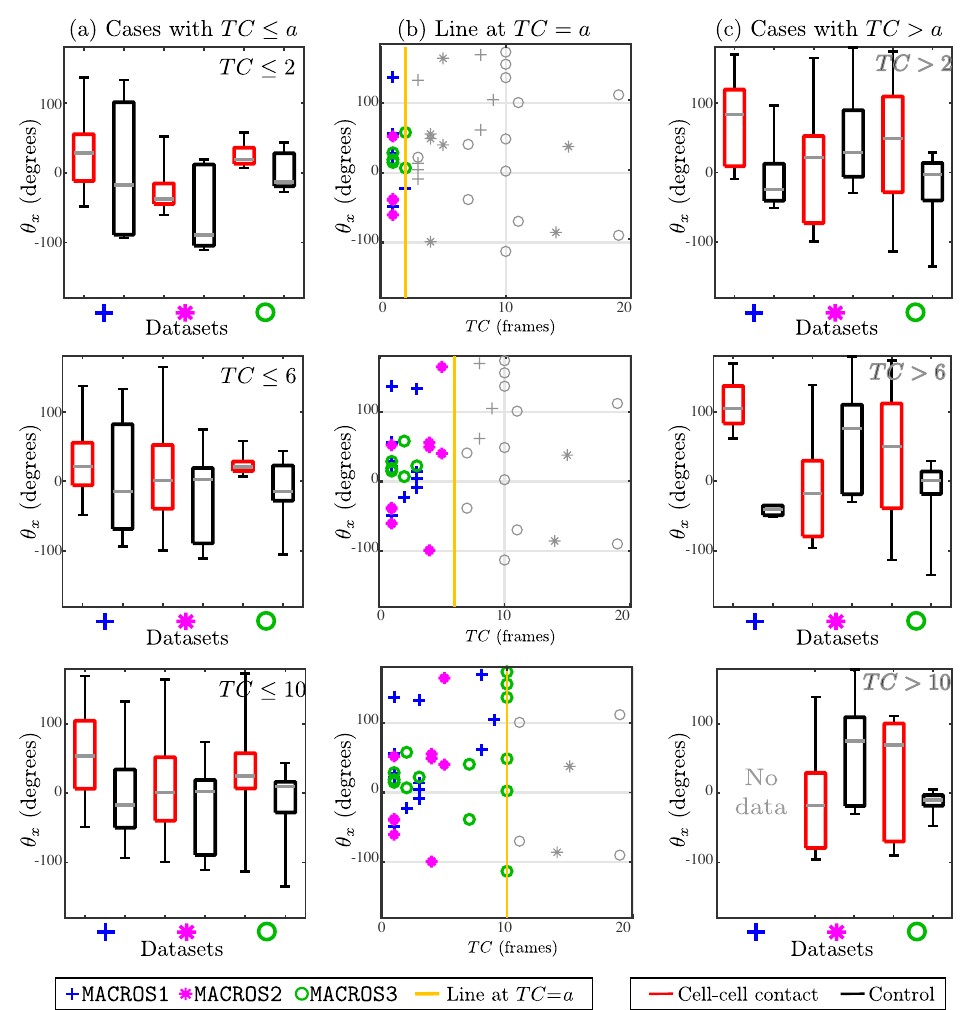
Figure 12. Comparison of angle change, depending on the time spent in clumps . In both datasets, boxplots of the angle change were generated for experiments with cell–cell contact (red) and control movement (black). The figure should be read by rows, where each one corresponds to a specific number of frames the cells remained in a clump (Time in clump : TC = a , a = 2,6,10). The left column shows boxplots of the experiments that fulfil the criterion TC ≤ a and the right column show the experiments where TC > a . The middle column shows scatter plots showing all cases from both